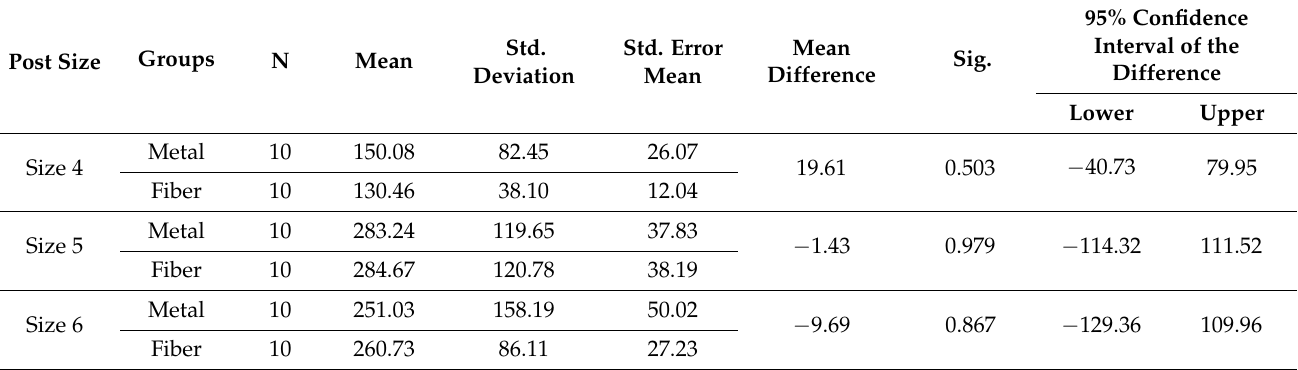
Table 4. Group statistics (independent sample’s t -test) of the specimens based on the type of posts.